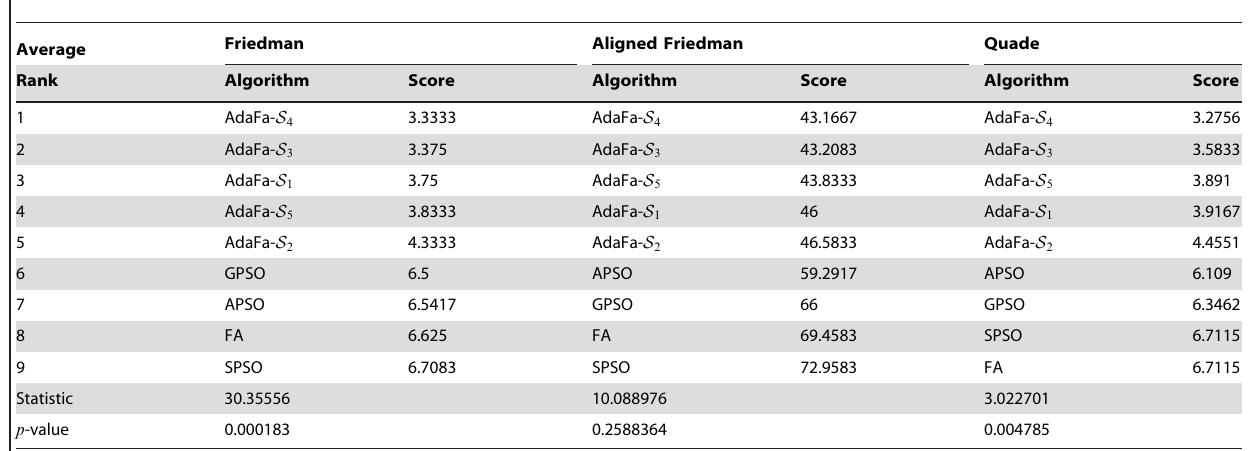
Table 2. Average Ranks of all compared algorithms over all benchmark